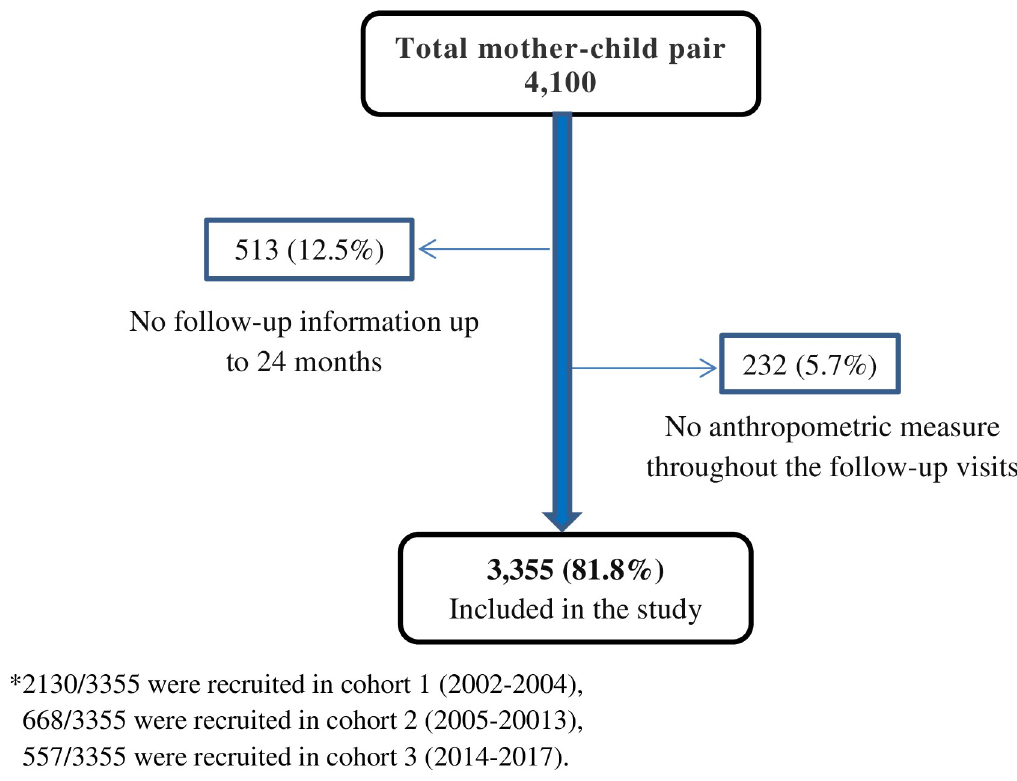
Fig 1. Flow chart for selecting mother-infant pairs to be included in the